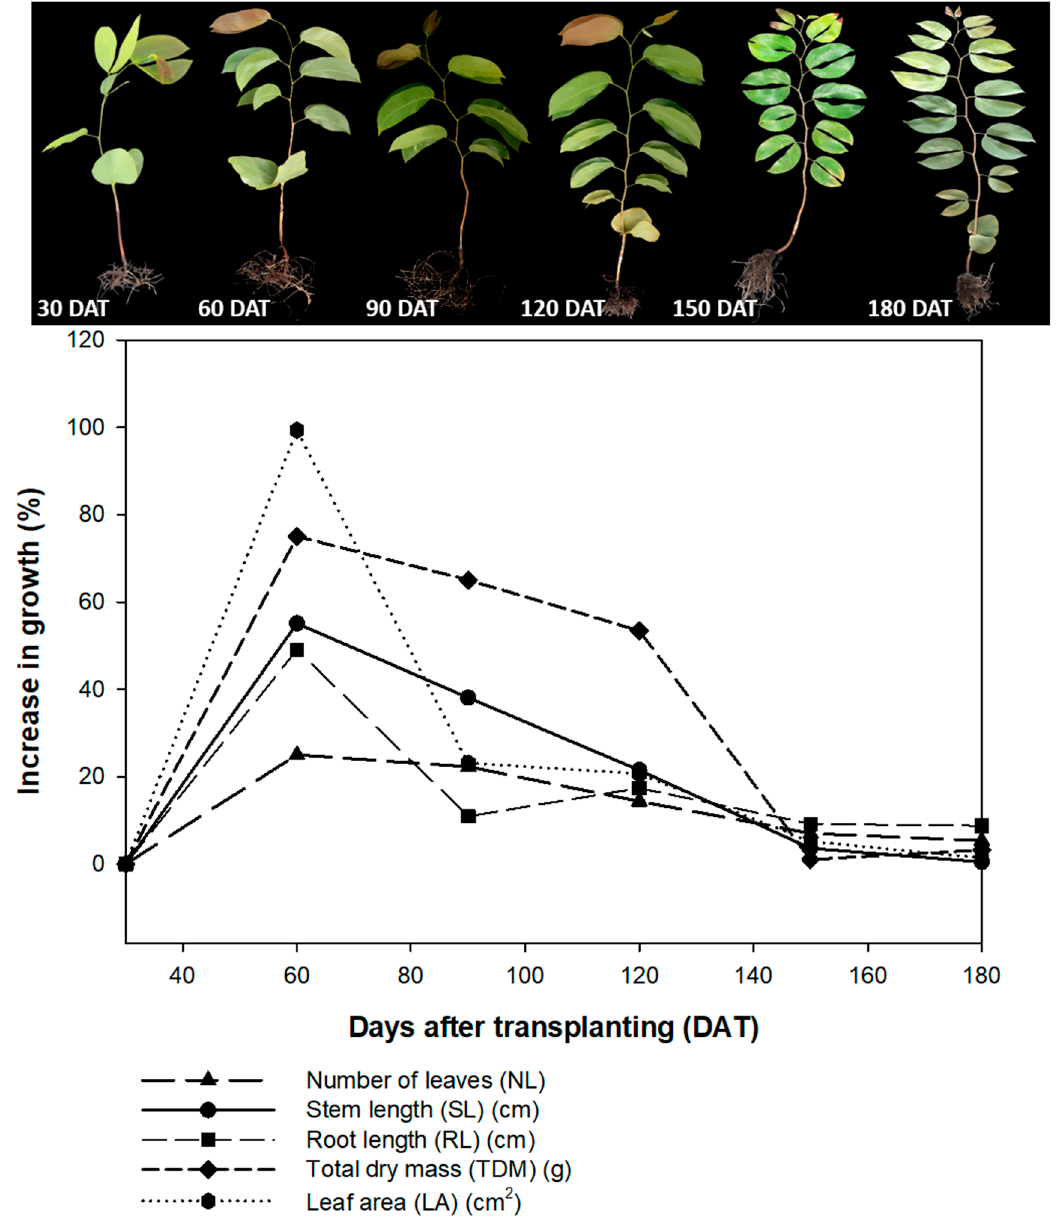
Figure 9. Percentage growth, number of leaves (NL); stem length (SL); root length (RL); total dry mass (TDM), and leaf area (LA) of the seedlings of Hymenaea courbaril L. cultivated in a hydroponic system and sampled at 30-day intervals across their initial development (30, 60, 90, 120, 150, and 180 days after transplantation).